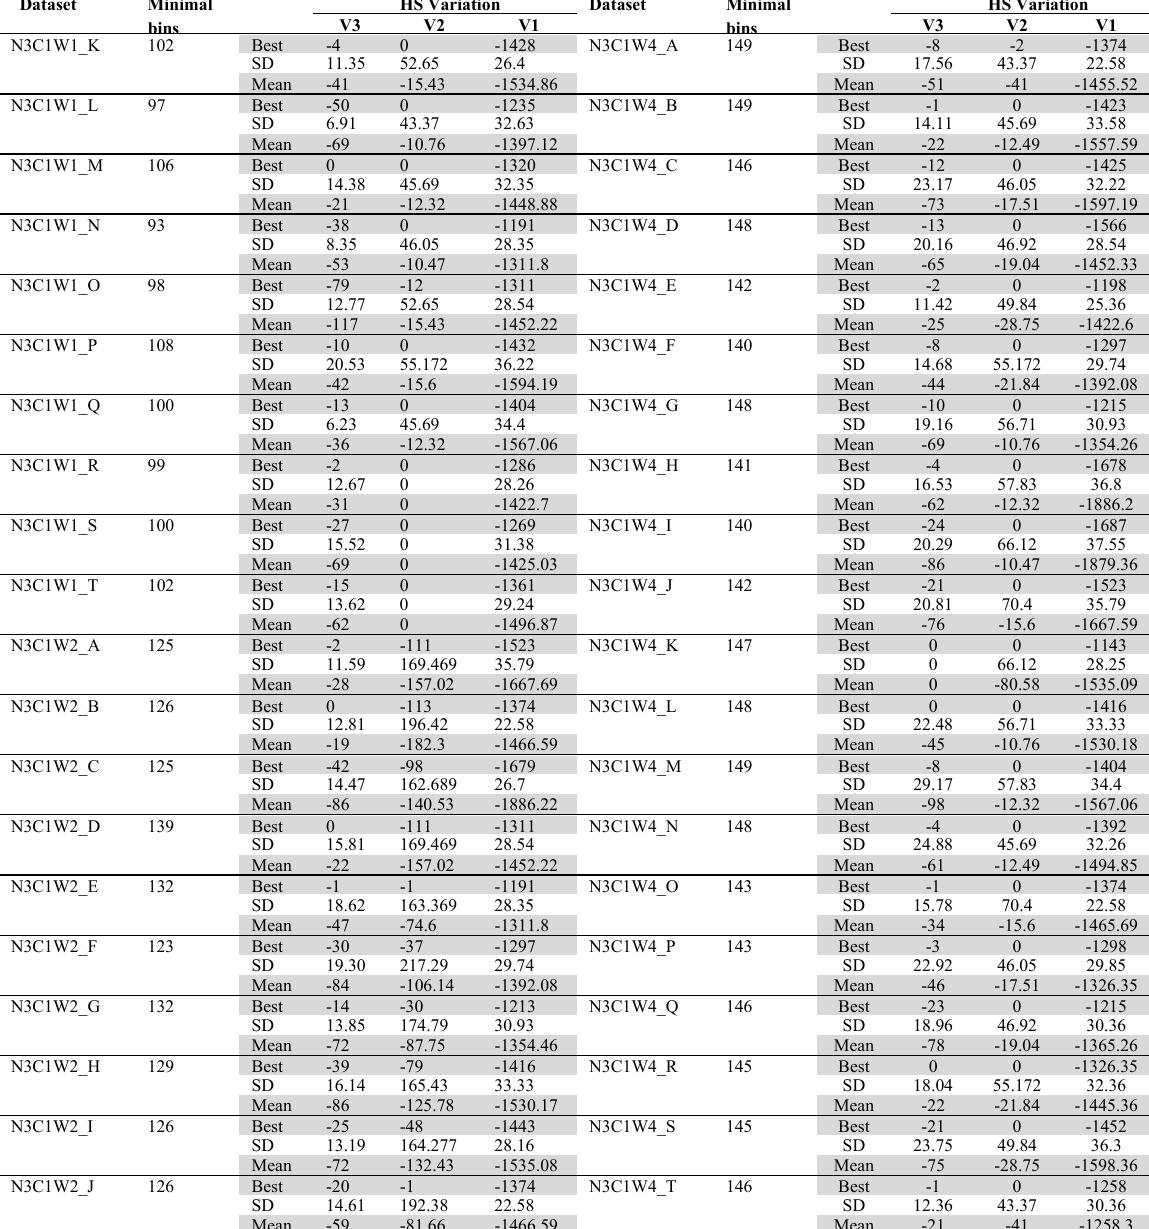
Best, mean and standard deviation values of proposed HS variations for 60 datasets with 200 objects (Continued)